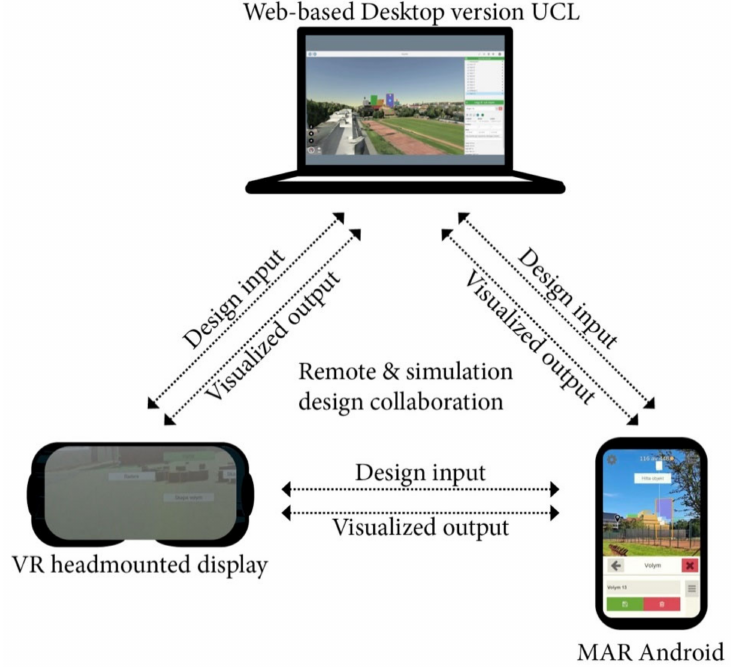
Figure 3. Synchronizing web-based desktop stations, VR and MAR.